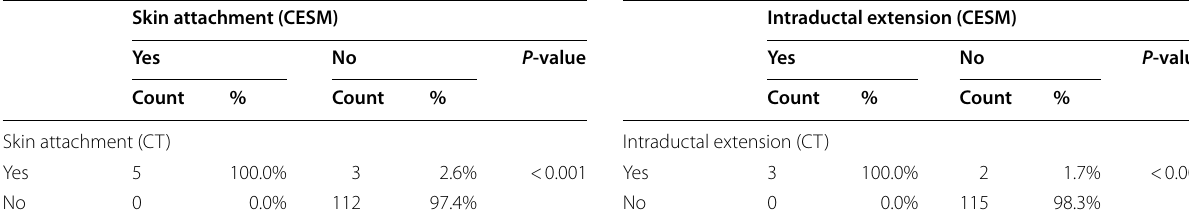
Table 6 Association between CESM and MDCT assessment